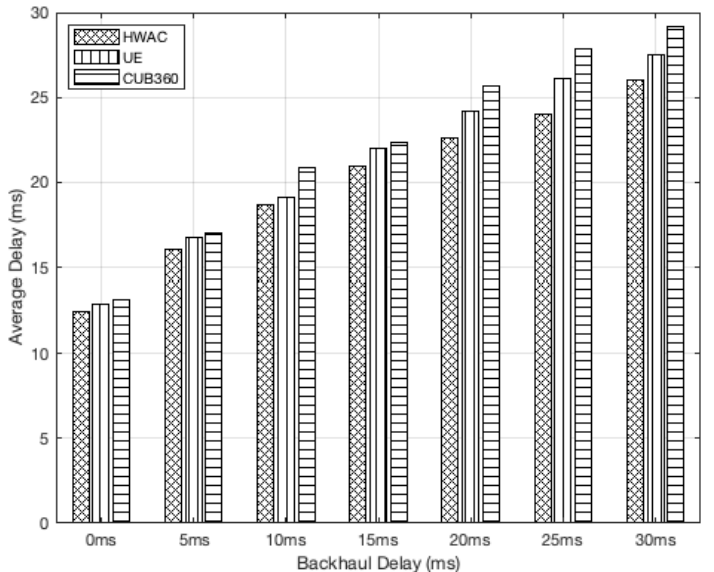
Figure 7. Average Latency